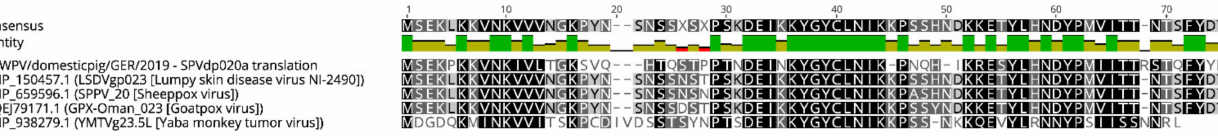
Figure 5. Alignment of the predicted amino acid sequence of a hypothetical protein encoded by the novel SPVdp020a present downstream of SPVdp020 in SWPV/domestic/GER/2019 with predicted proteins encoded by other poxviruses which display the closest predicted homology. The alignment and analysis were performed using Geneious Prime (Biomatters,